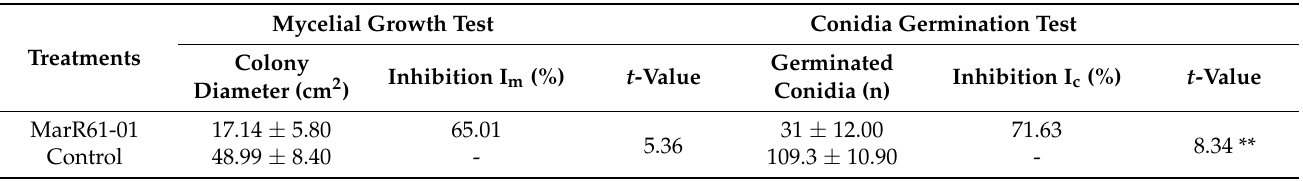
Table 2. Inhibitory effect of VOCs produced by Serratia rubidaea MarR61-01 against Botrytis cinerea under in vitro